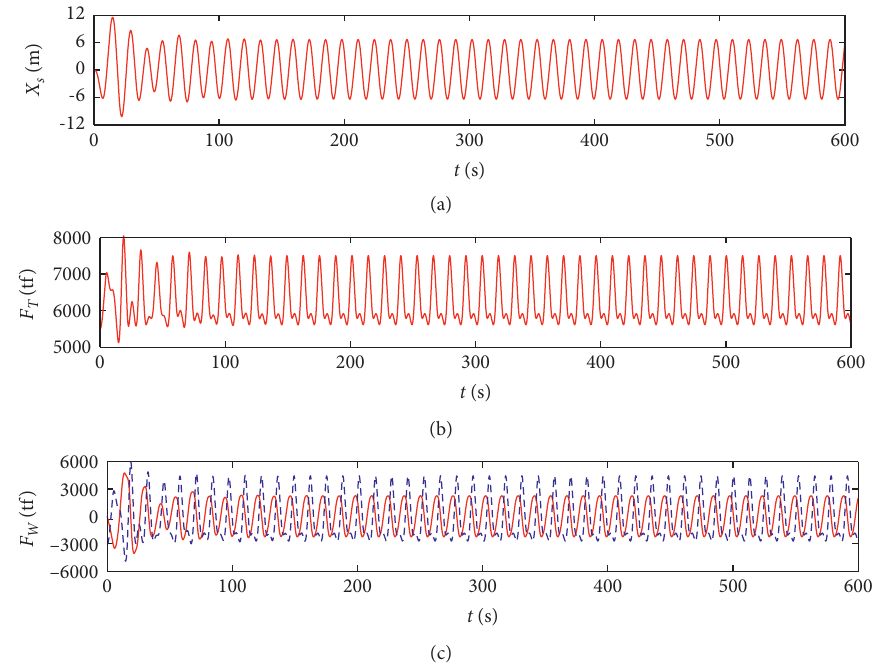
Figure 7: The time history of (a) tube displacement X s , (b) mooring cable tension F T , and (c) wave force F W (the solid line represents horizontal wave force and the dotted line represents vertical wave force) under wave period equal to 13s, wave steepness equal to 0.04, and BWR equal to 2.6.